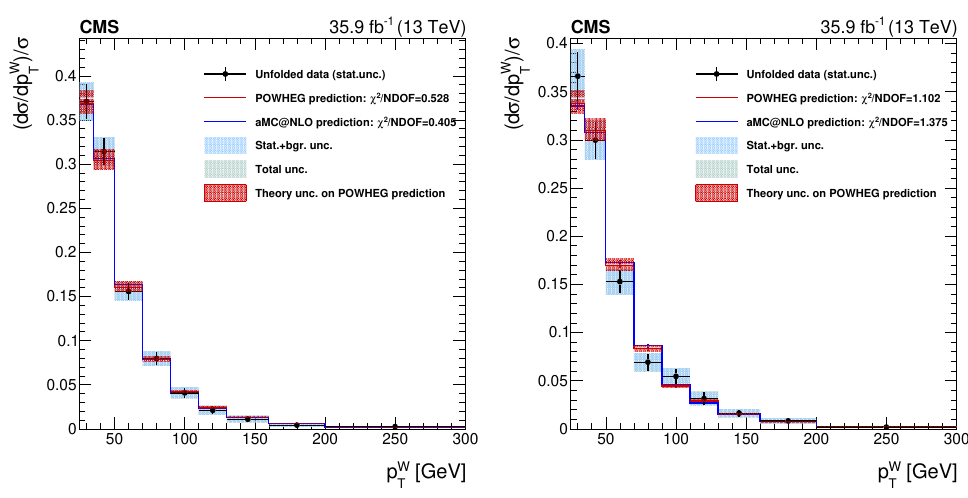
Figure 14 . Di(cid:11)erential distributions for W + (left) and W (cid:0) (right), in the full SR. The W boson transverse momentum is unfolded at the dressed leptons level, as described in the text. The red band around the powheg prediction represents the theory uncertainty in it; the e(cid:11)ect on the unfolded data of this uncertainty, through the unfolding matrix, is included in the shaded bands described in the legend.